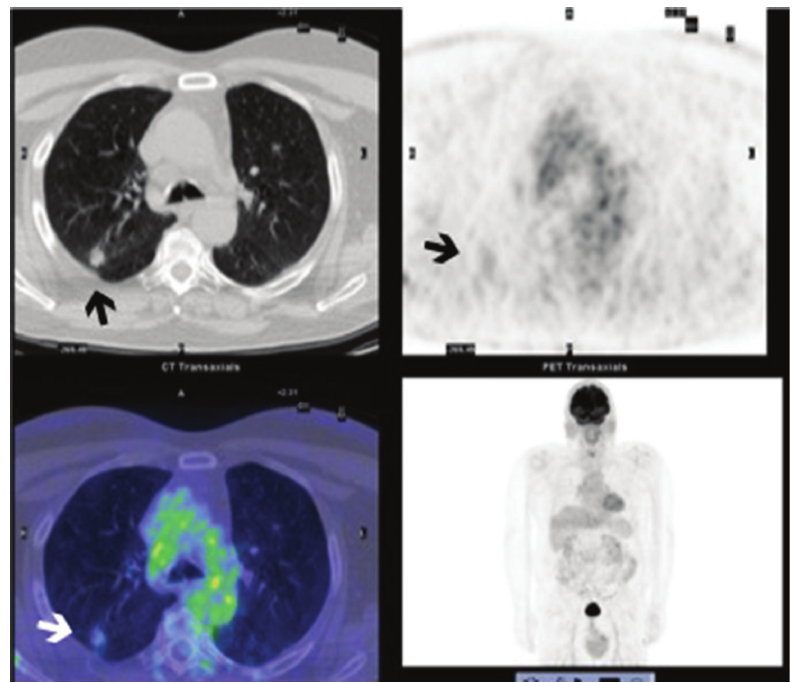
Figure 4: Faintly 18 F-FDG uptake of the right pulmonary upper lobe—SUVmax 1.3 (arrow).